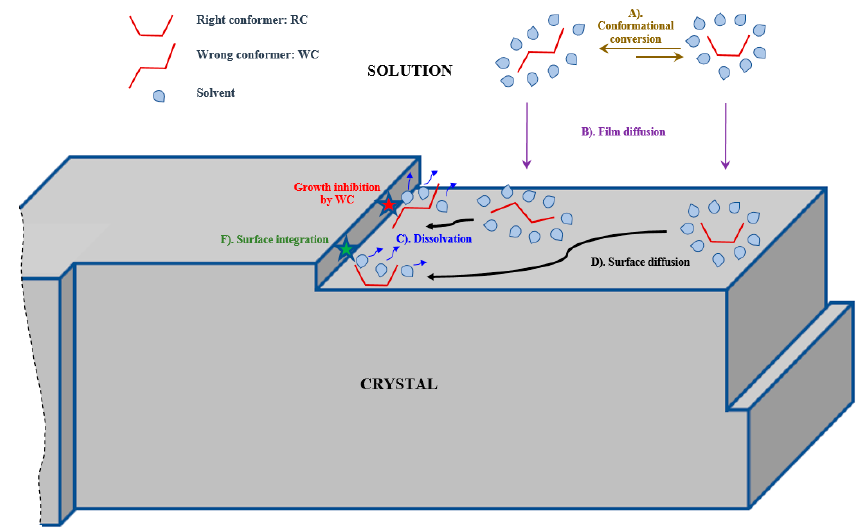
Figure 1. Elementary processes occurring during crystallization from solution containing slow inter-converting conformers.